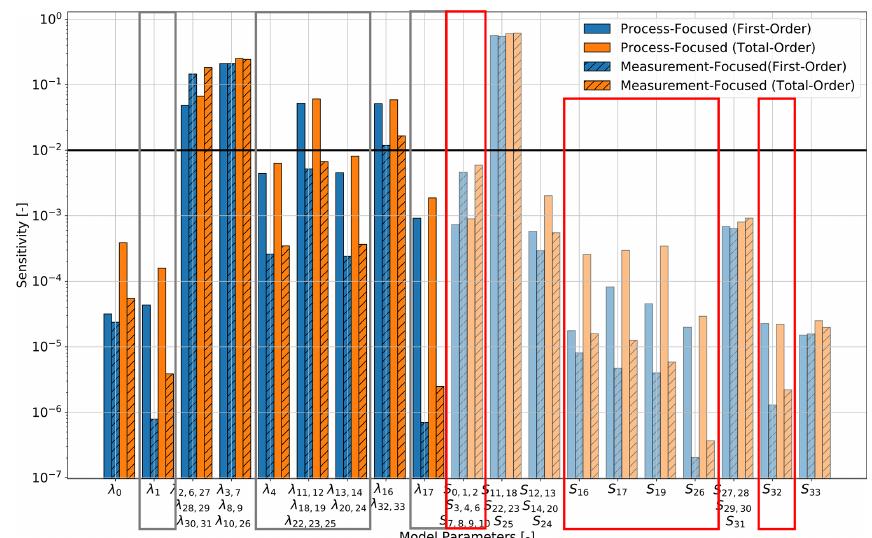
Figure 6. Top-level sensitivity analysis (focusing on the entire Alps model) with different quantities of interest of the hierarchical global sensitivity analysis for the General-Focus Alps model. For the layer IDs and symbols, please refer to Table A1. The solid black line denotes the threshold value for determining if the parameters are influencing the model response.